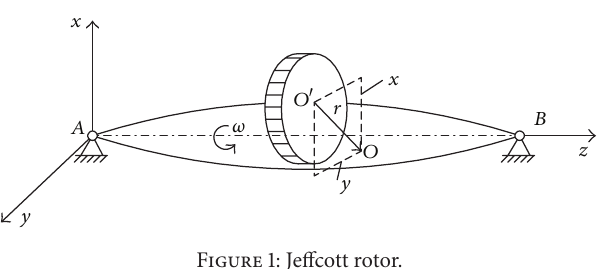
Figure 1: Jeffcott rotor.